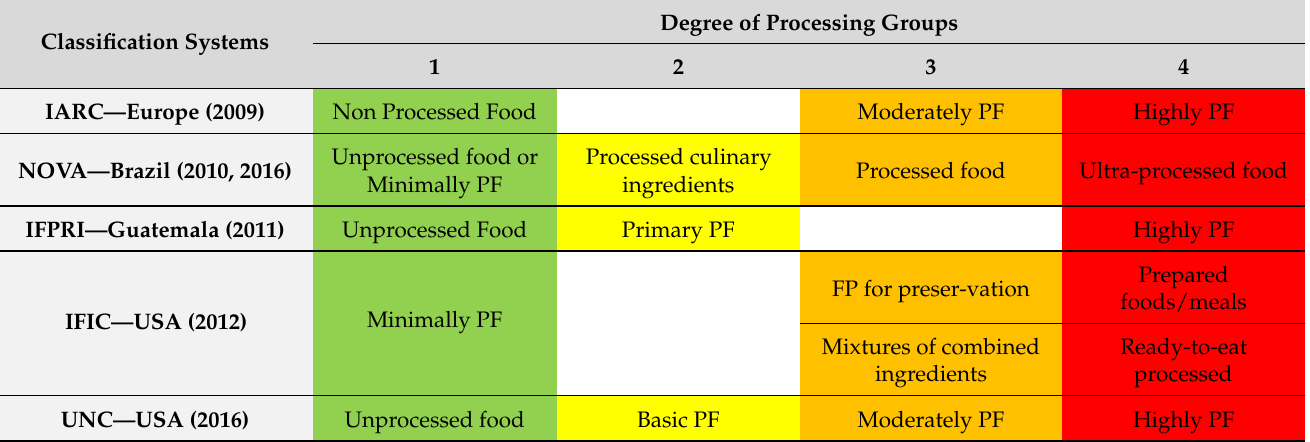
Table 2. Comparison among food processing classification systems: summary of differences and